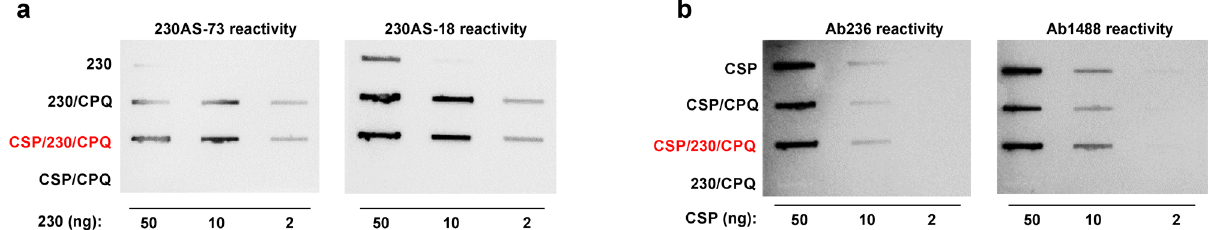
Fig. 2 Liposome-displayed malaria antigens maintain conformational integrity. Slot blot detection of mAb binding to adsorbed Pfs230D1 + and CSP in soluble or particulate form. Human monoclonal antibodies that target ( a ) Pfs230 (230AS-73 and 230AS-18) or ( b ) CSP (Ab236 and Ab1488) were incubated with the membrane and bound mAbs were detected using a chemiluminescent secondary antibody. Red text indicates bivalent, liposome- displayed